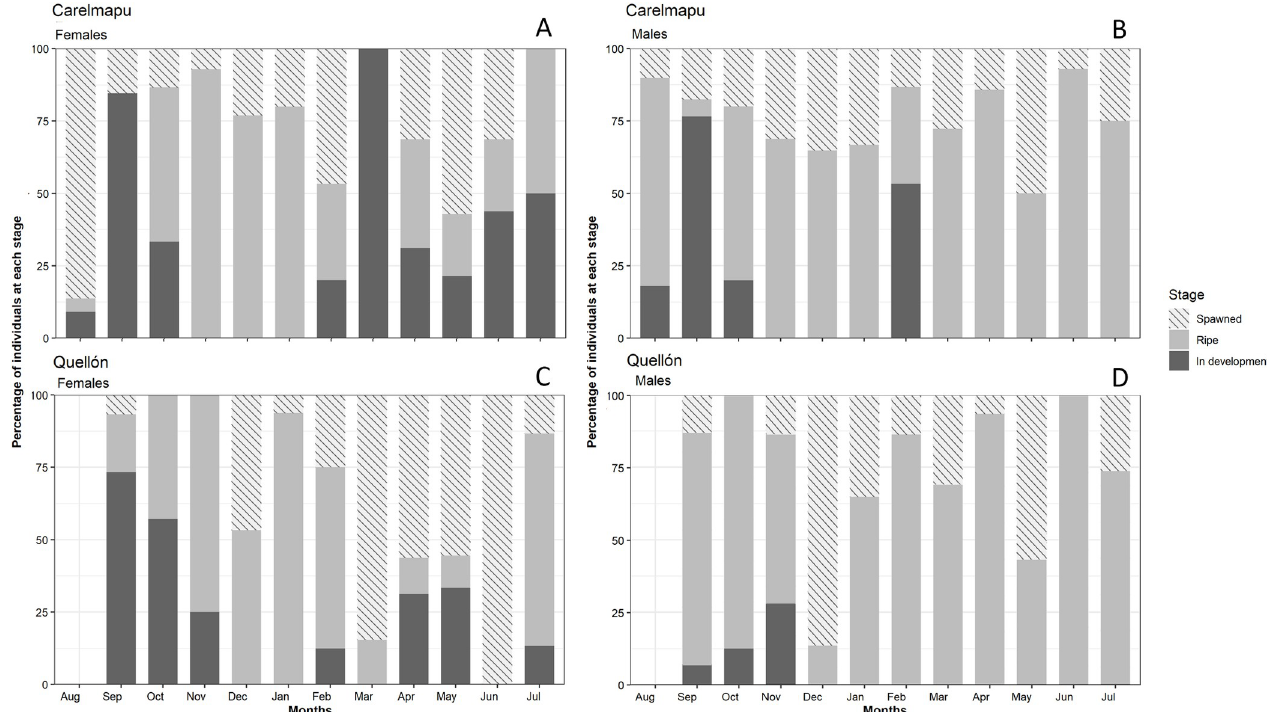
Fig 3. Temporal variation in the state of maturity in clams A . antiqua . (A) State of maturity of females at Carelmapu locality. (B) State of maturity of males at Carelmapu. (C) State of maturity of females at Quello´n locality. (D) State of maturity of males at Quello´n.